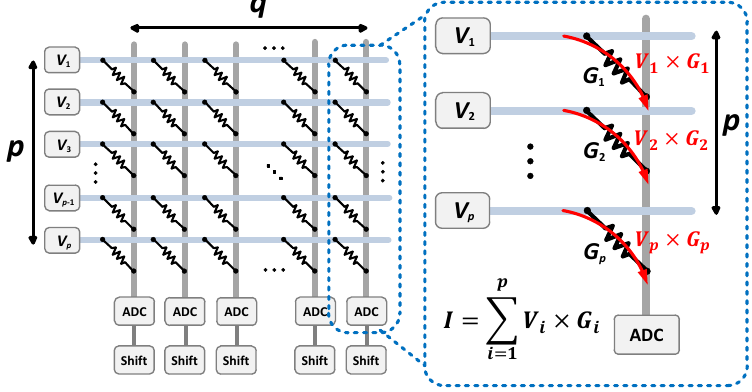
Figure 1. Target hardware model.